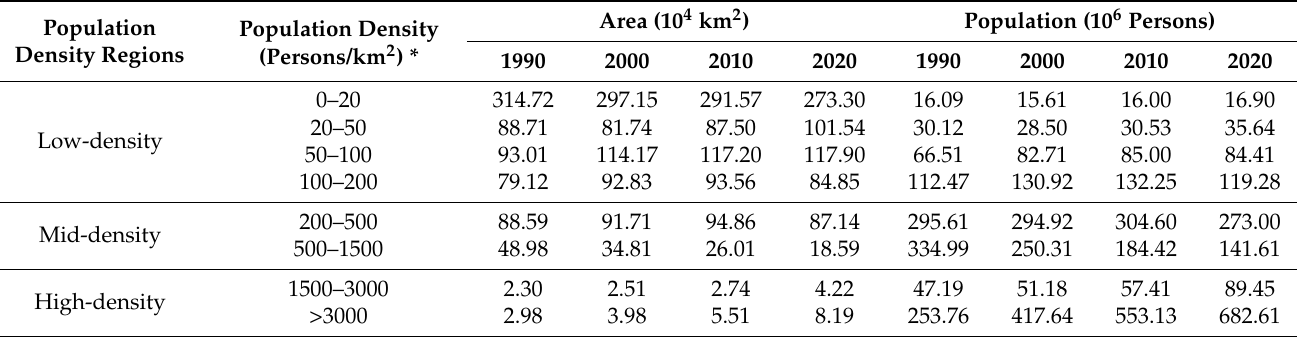
Table 4. Changes in the population density distribution of China in 1990–2020.